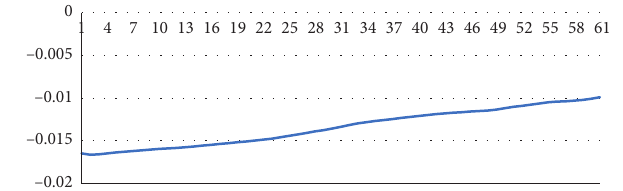
Figure 8: Time series of network system activity